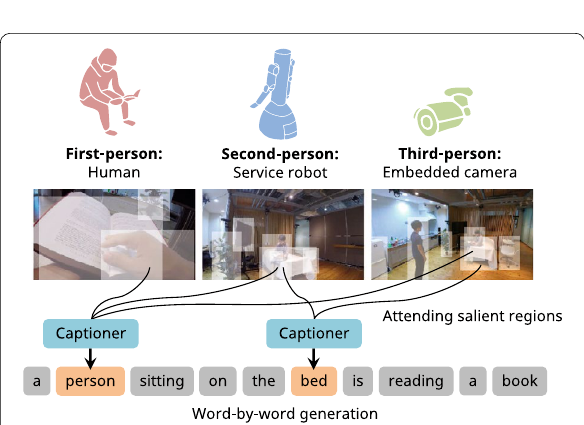
Fig. 2 Our concept of lifelogging caption generation in a human–robot symbiotic environment. The system is composed of the first-person perspective from a human, the second-person perspective from a service robot, and the third-person perspective from an embedded camera. Fragmental visual concepts are adaptively weighted and processed to predicting each